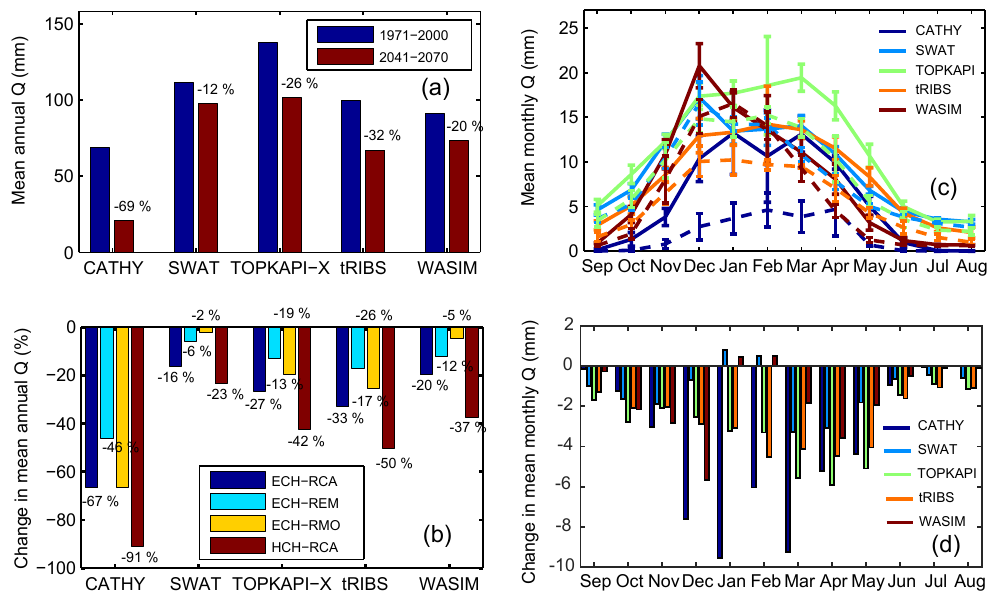
Figure 7. As Fig. 6, but for discharge ( Q ) simulated by each hydrologic model forced by the four selected climate models for the reference (REF, 1971–2000) and future (FUT, 2041–2070) periods. Table 3. Change (%) between future and reference periods of mean annual discharge ( Q ), soil water content (SWC), and actual evapotranspi- ration (ET a ) for the five hydrologic models (CAT: CATHY, SWA: SWAT, TOP: TOPKAPI, TRI: tRIBS, WAS: WASIM), expressed as mean ( µ ) and standard deviation ( σ ) calculated for each and then all hydrologic models (HMs) considering all climate models (ERC: ECH-RCA,